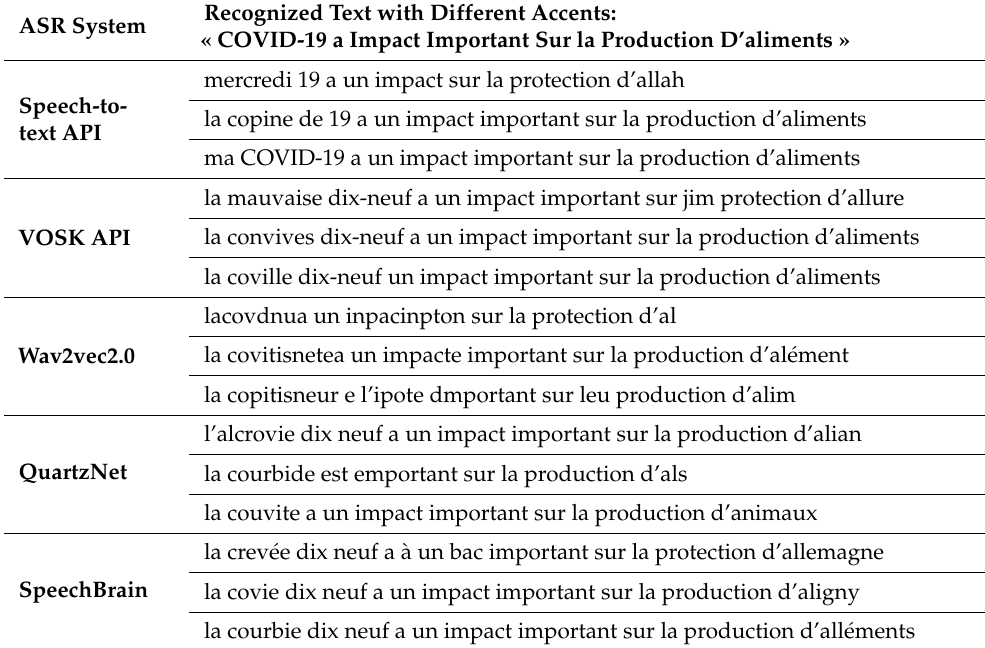
Table A1. Speech recognition examples from various ASR systems on Moroccan French